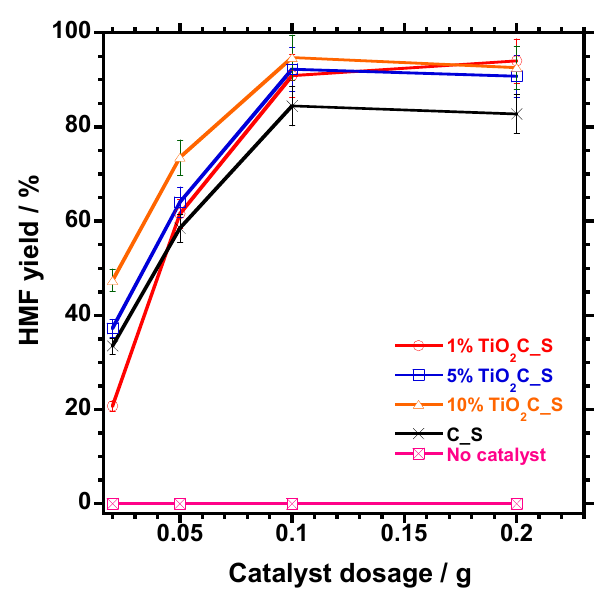
Figure 8. Effect of catalyst dosage on the dehydration of fructose into HMF in DMSO solvent.